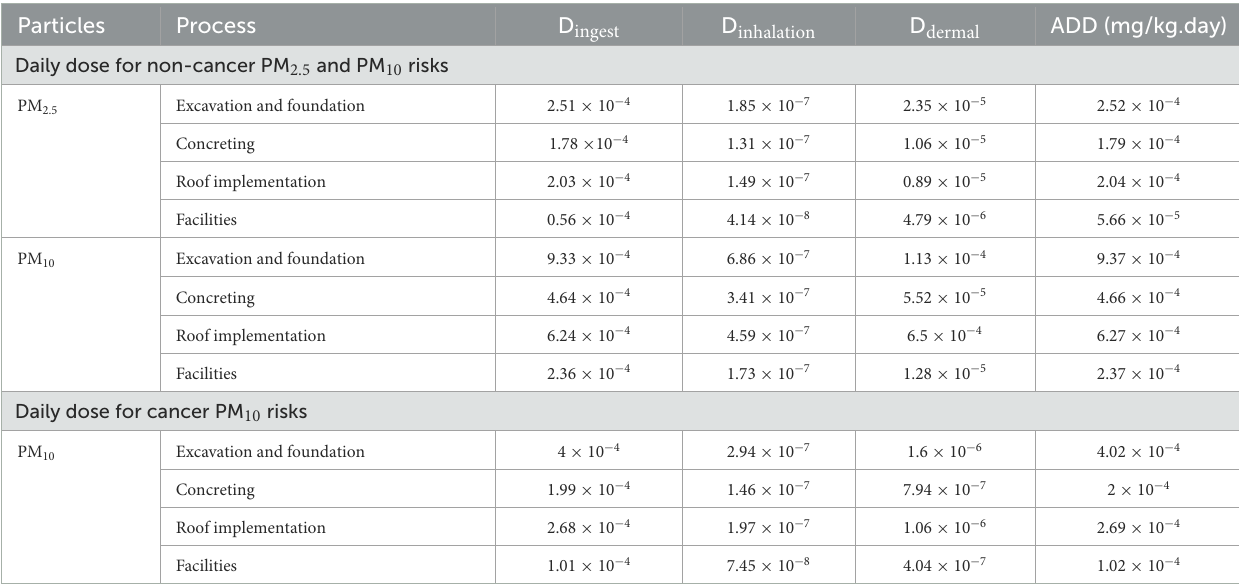
TABLE 2 Daily exposure dose values for non-cancer and cancer PM 2.5 and PM 10